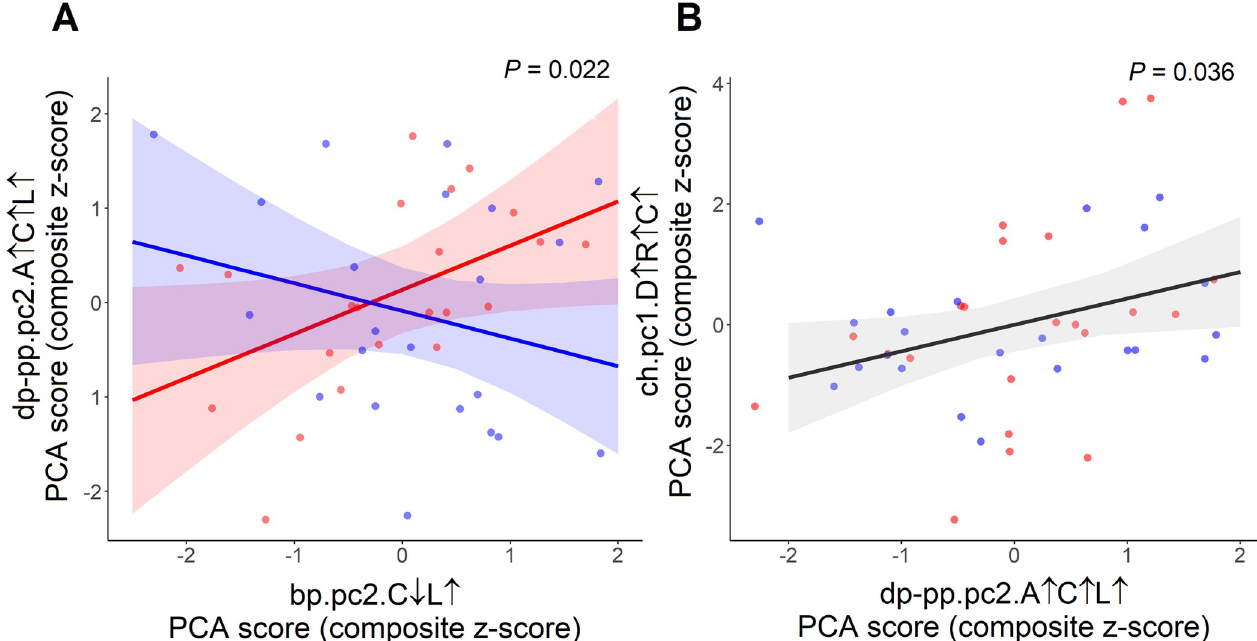
Fig 3. A. Maternal multiple micronutrient supplementation affects associations between maternal biomarker components. Interaction between baseline maternal PC2 bp.pc2.C # L " and supplementation type with post-supplementation maternal PC2 dp-pp.pc2.A " C " L " . B. Effect of maternal biomarker component on child biomarker component. Association of maternal PC2 dp-pp.pc2.A " C " L " and child PC1 ch.pc1.D " R " C " . Blue line and blue dots: MMN supplementation; Red line and red dots: IFA supplementation.